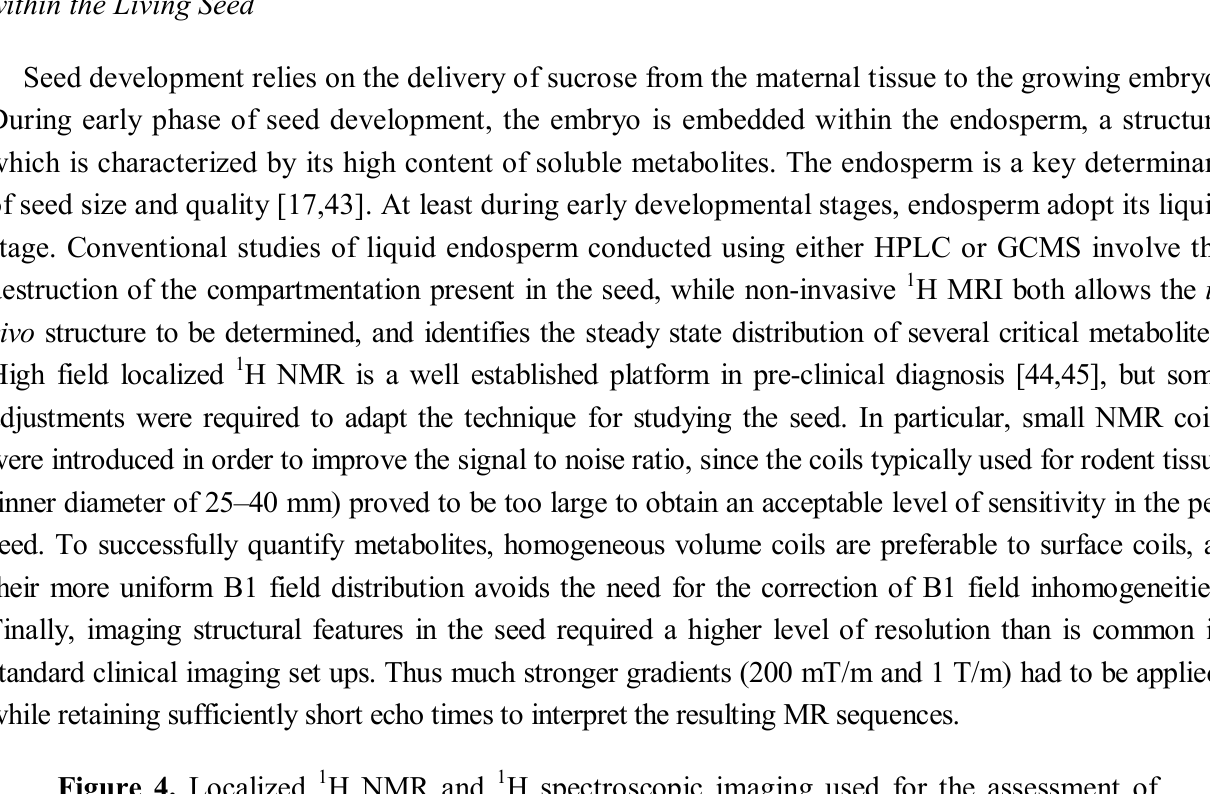
Figure 4. Localized 1 H NMR and 1 H spectroscopic imaging used for the assessment of metabolite distribution within an intact living seed. Reference and metabolite images of the pea seed of DW 120 mg (left) and 250 mg (right). Localized spectra of the pea endosperm (right panel). Upper spectrum: 120 mg DW seed, lower spectrum: 250 mg DW seed. A lower alanine (Ala) and glutamine (Gln) signal was obtained from the younger